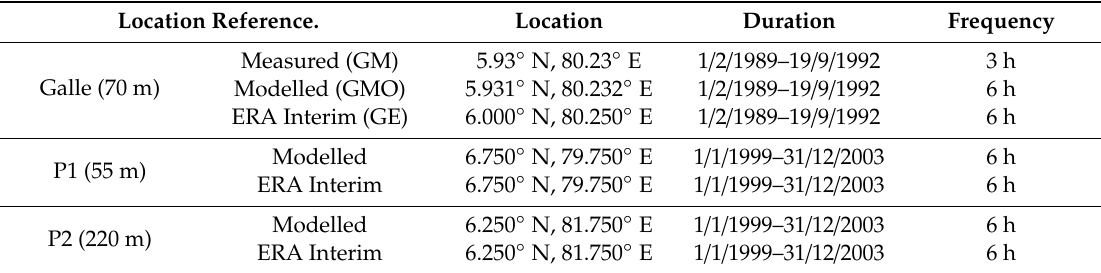
Table 1. Locations and details of measured, ERA-Interim Global Atmospheric Reanalysis and modelled wave data used for Sri Lanka regional wave model validation. Water depths are given in brackets in column 1.